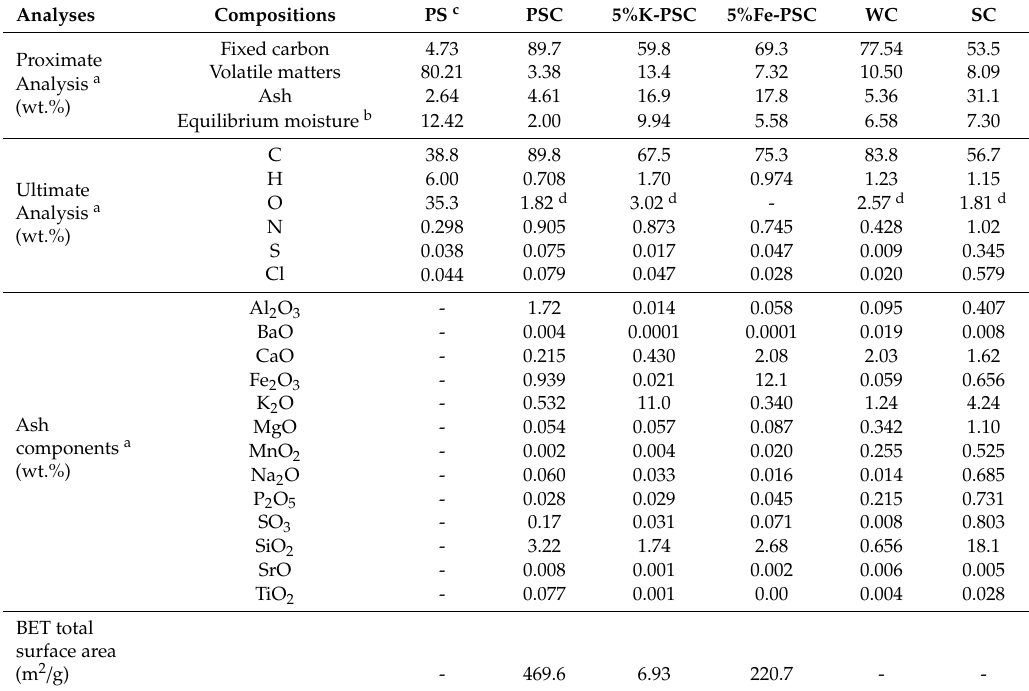
Table 2. Characteristics of PS, PSC, 5%K-PSC, 5%Fe-PSC, WC, and